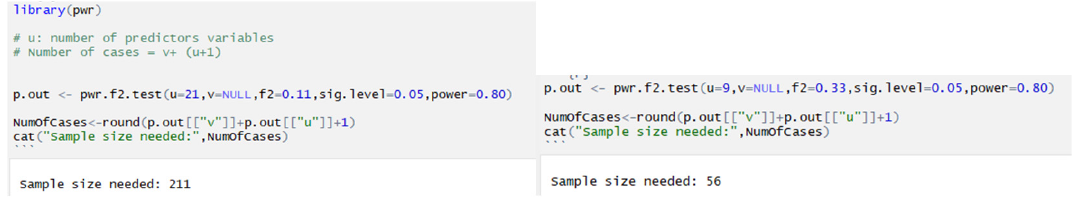
Figure 10. A priori calculation of statistical power with